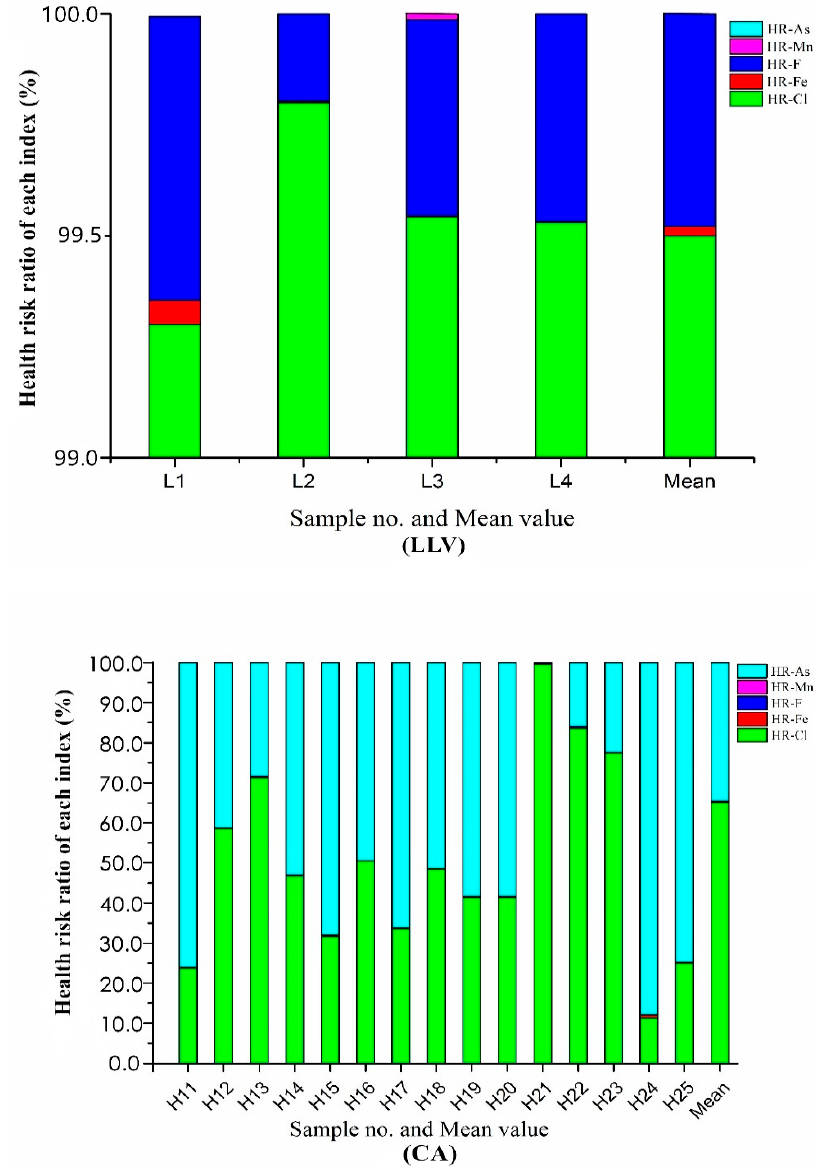
Figure 4. Health risk ratio of each index in the two control groups.